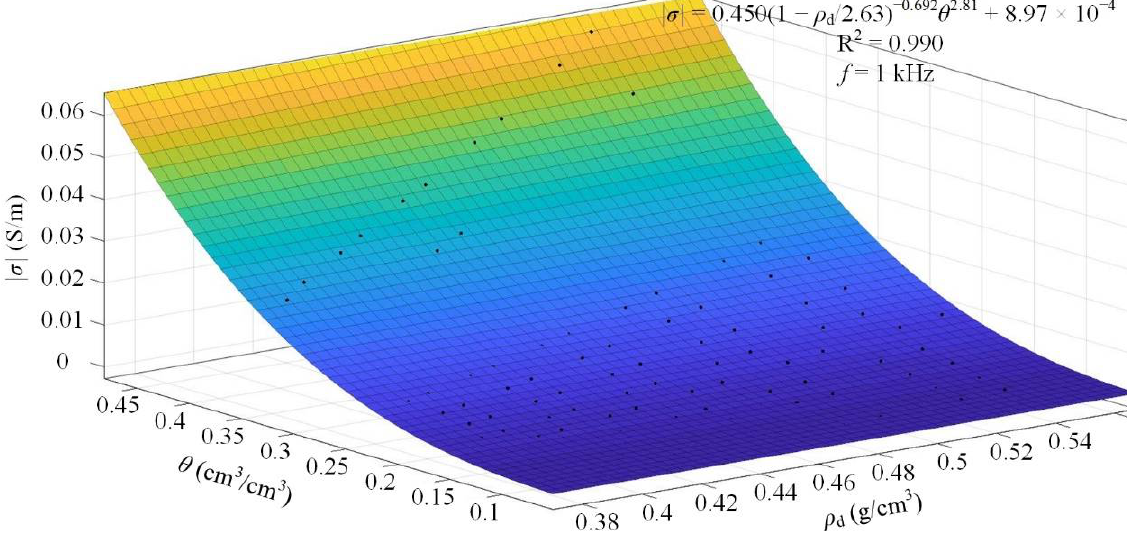
Figure A6. Fitted relation for substrate conductivity magnitude as a function of volumetric water content and dry density at the frequency of 1 kHz. The related dry densities and VWCs are shown in Tables S1 and S2, respectively.